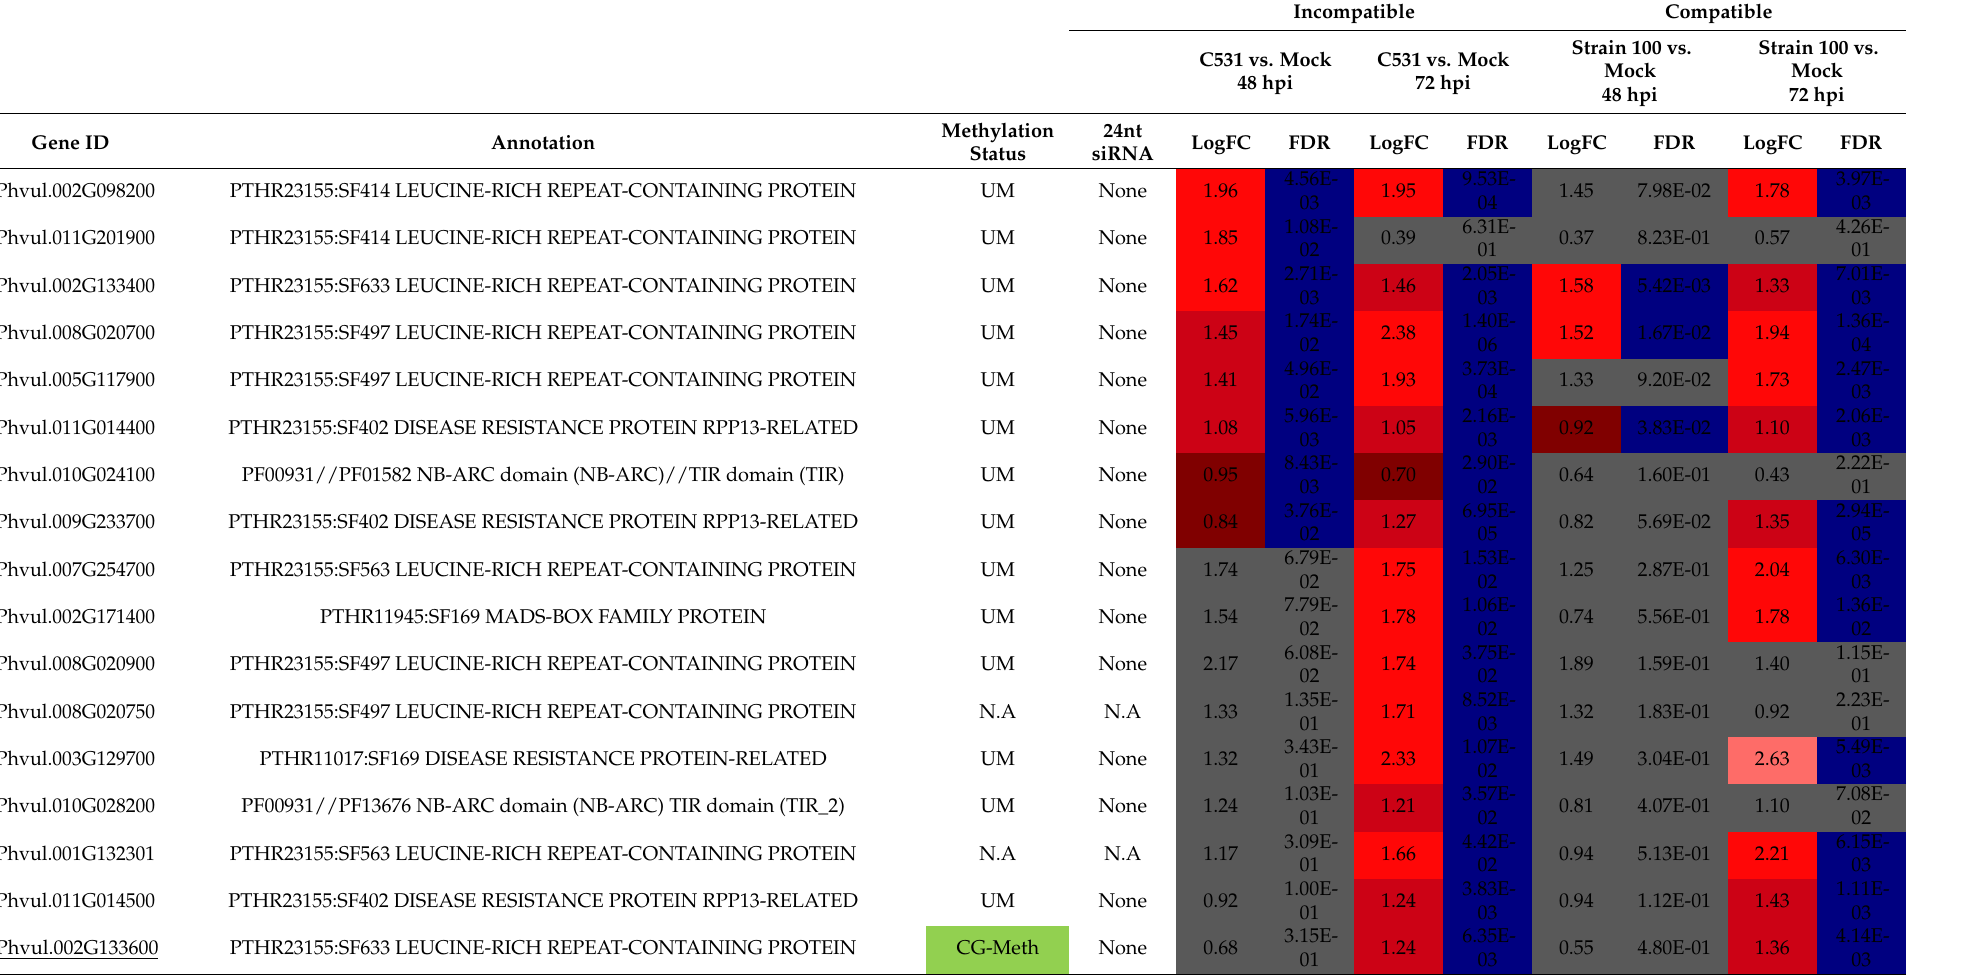
Table 1. List of significantly differentially expressed NLRs in compatible and incompatible interaction, at 48 hpi and 72 hpi.